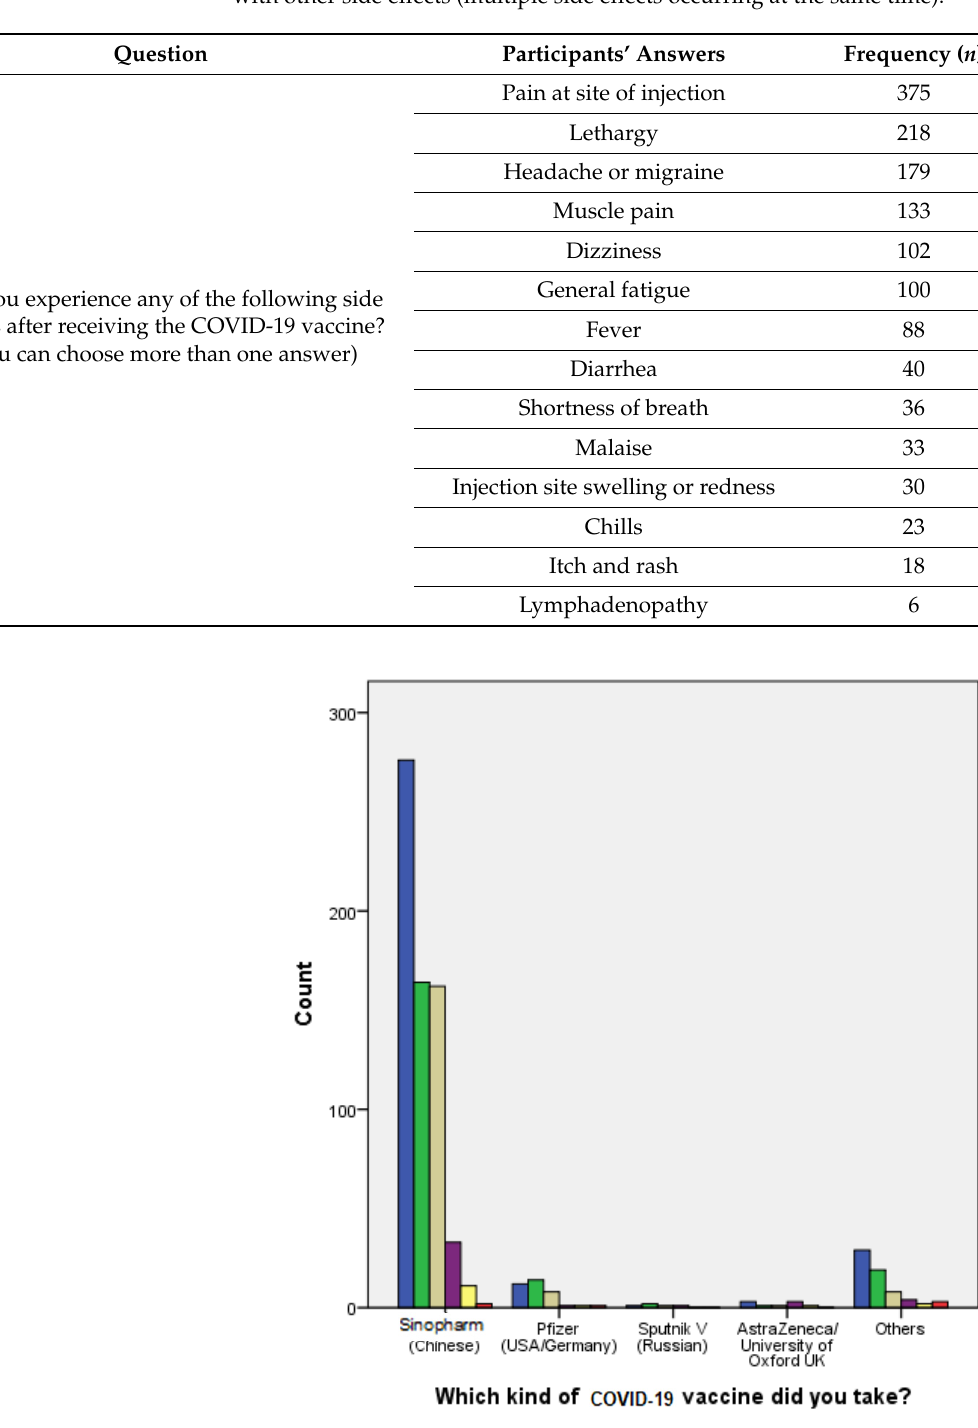
Figure 2. Reported severity of vaccines’ side effects. Table 6. Post-vaccination side effects severity rank according to number of doses.